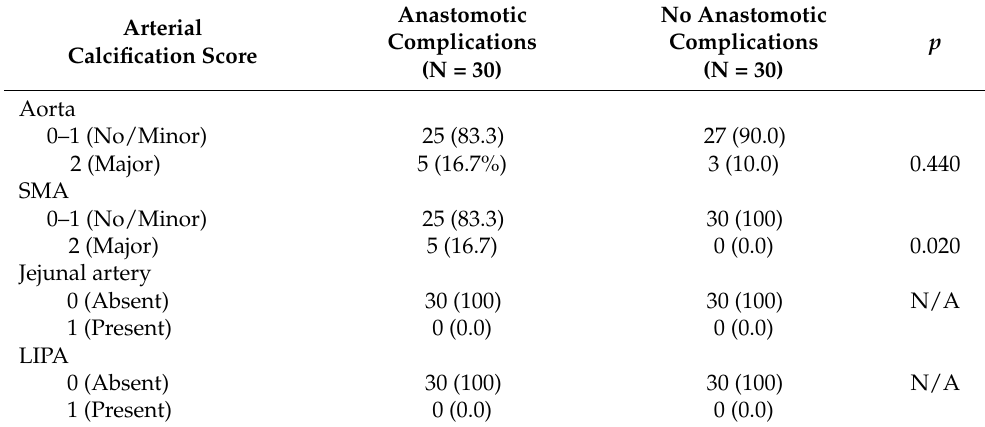
Table 3. Association between arterial calcifications with esophagojejunal anastomosis complications. Anastomotic Arterial Complications Calcification Score